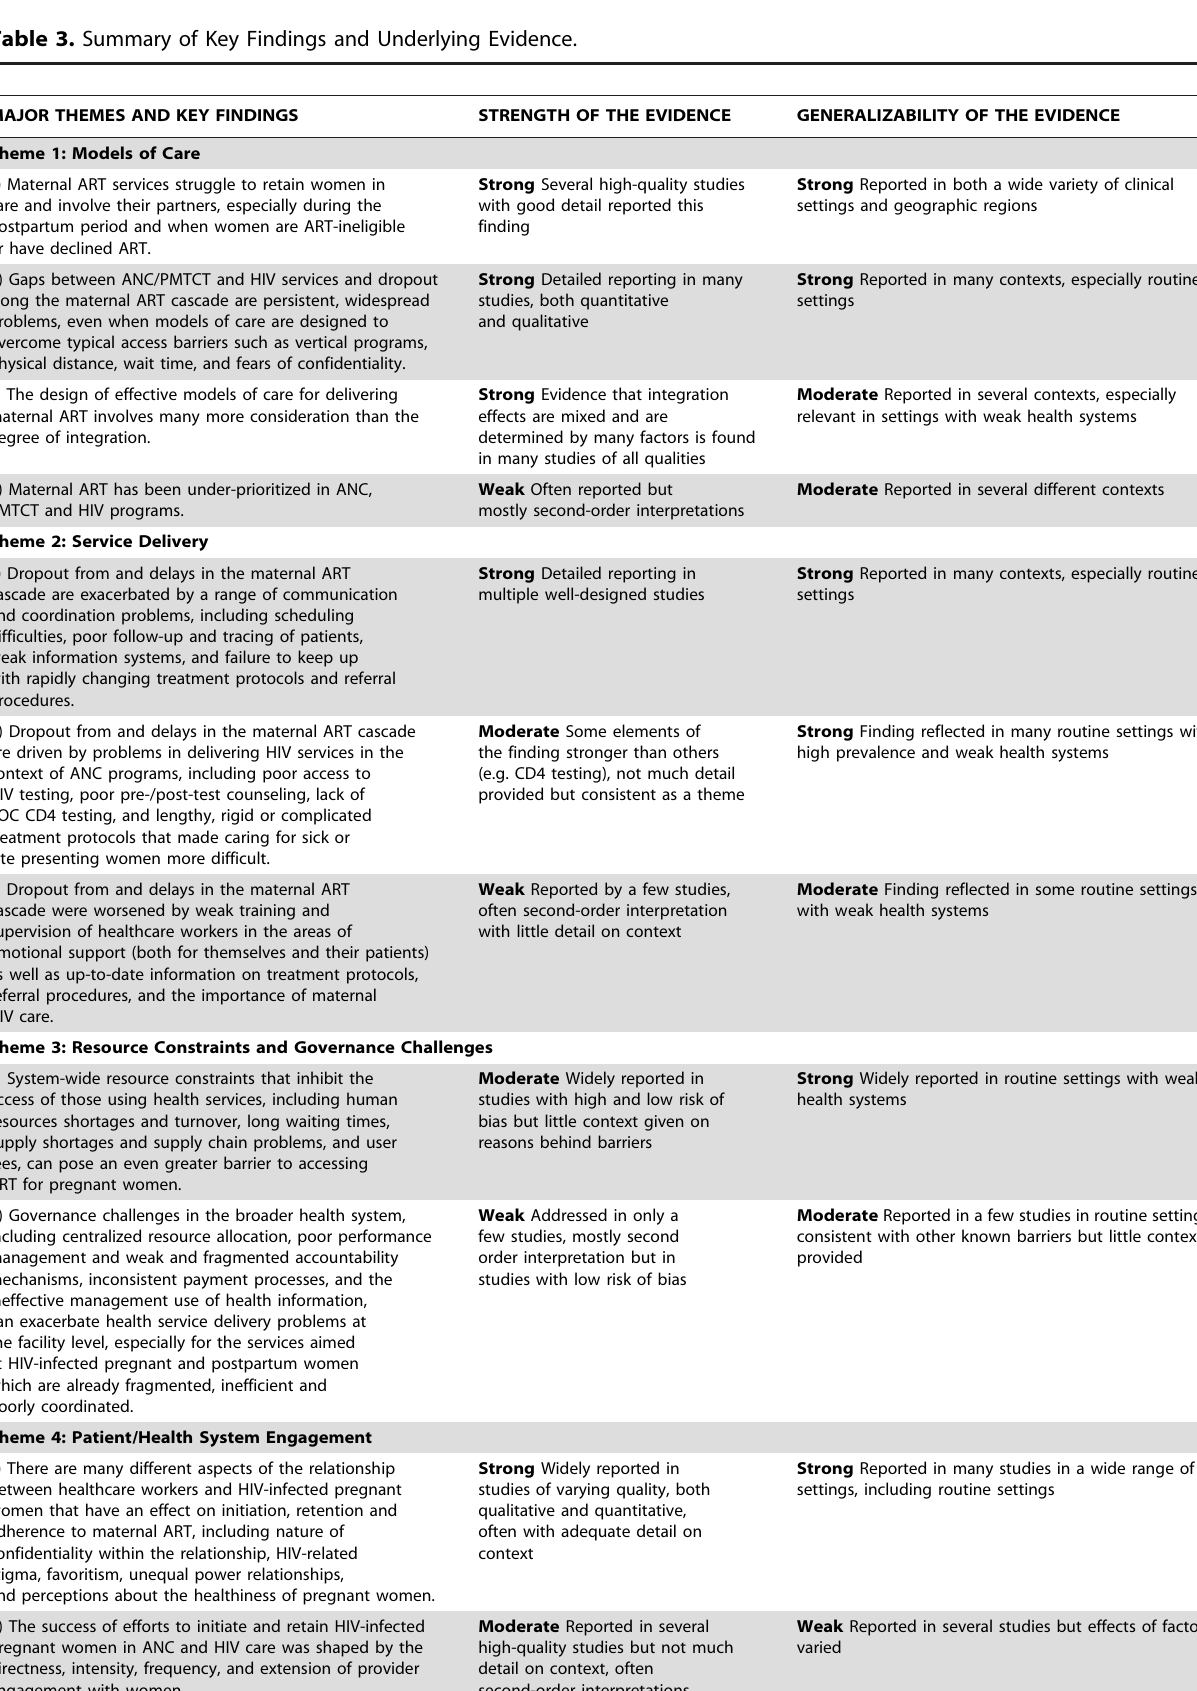
Table 3. Summary of Key Findings and Underlying